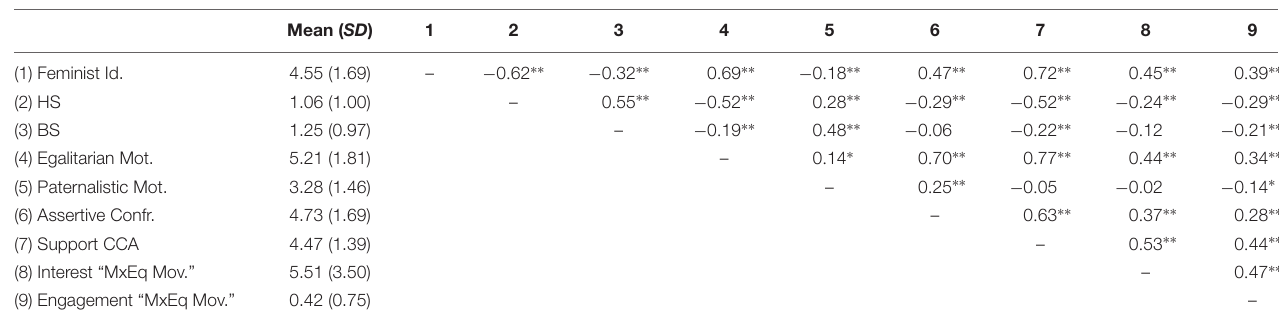
TABLE 3 | Means, standard deviations, and correlations for Study